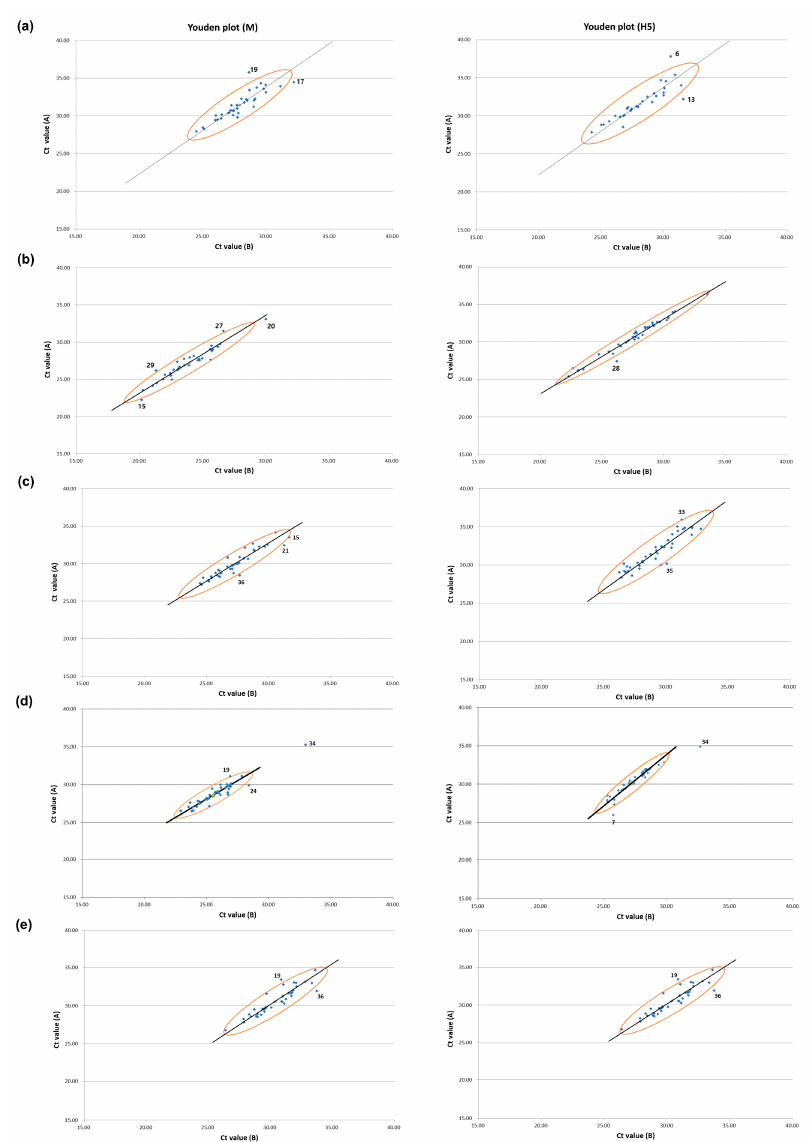
Figure 2. Youden plots of M and H5 genes for laboratories participating in five PT rounds. Ct values for M and H5 genes of the paired CDSs were used to illustrate Youden plot for ( a ) 2020 first half, ( b ) 2020 second half, ( c ) 2021 first half, ( d ) 2021 second half, and ( e ) 2022. The X- and Y-axis values of blue dots indicate the Ct values for target gene of the paired CDSs (Ct value (A) and Ct value (B)). The Youden plots were drawn for M and H5, and 95% confidence ellipses, Manhattan medians, and reference lines were drawn. The laboratories located outside the 95% confidence ellipse were denoted with the number of